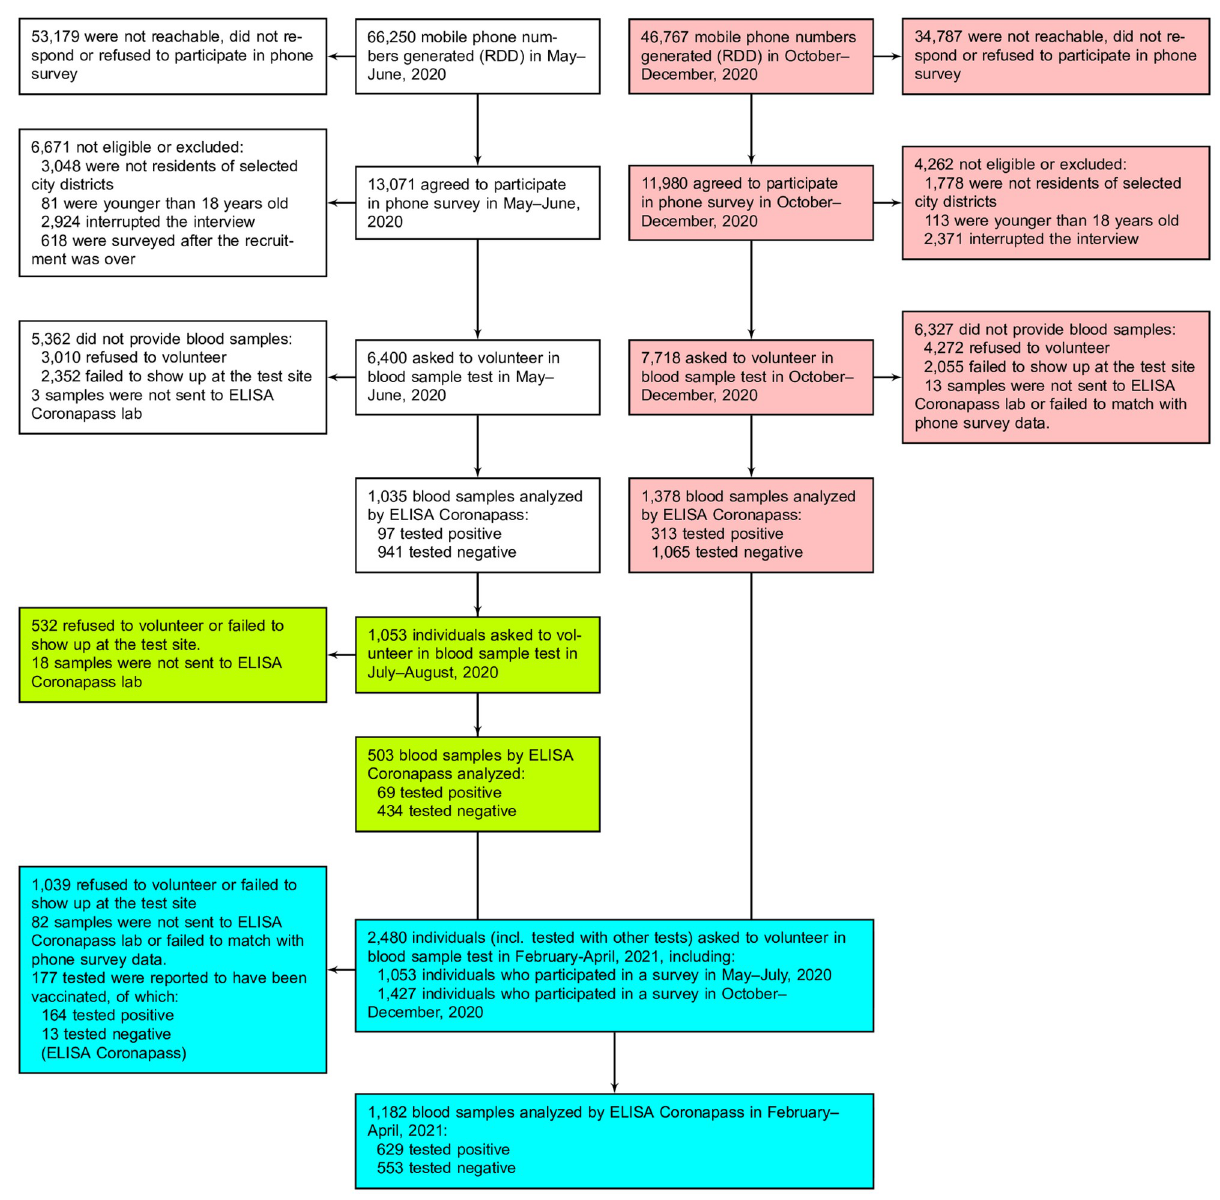
Fig 1. Flow chart of participants’ progress through the St. Petersburg seroprevalence study (color codes study cross-sections: White—cross- section 1 (2020-05-25—2020-06-28), green—cross-section 2 (2020-07-20—2020-08-08), pink—cross-section 3 (2020-10-12—2020-12-06), blue— cross-section 4